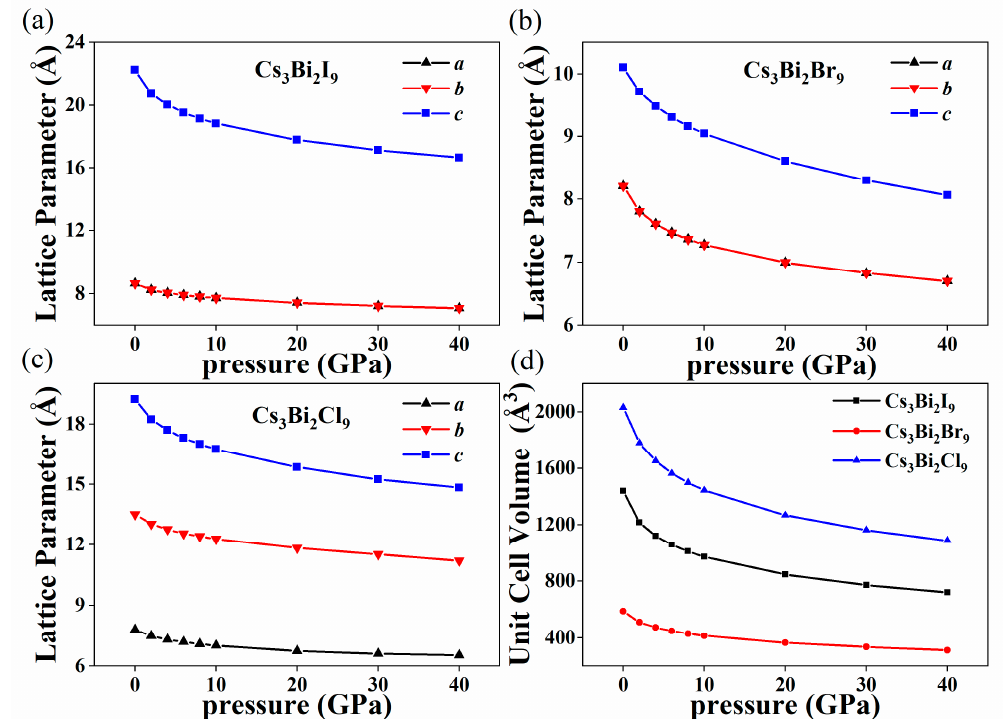
Figure 2. Changes in the calculated lattice parameter as a function of pressure from 0 GPa to 40 GPa for the Cs 3 Bi 2 I 9 perovskite ( a ), Cs 3 Bi 2 Br 9 perovskite ( b ), and Cs 3 Bi 2 Cl 9 perovskite ( c ). Changes in the unit cell volume of the Cs 3 Bi 2 X 9 perovskites under the pressures from 0 GPa to 40 GPa ( d ).